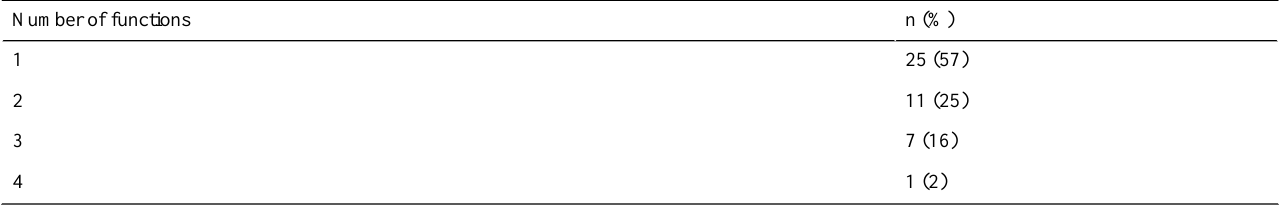
Table 1. Number of functions associated with caregiving apps (N=44).